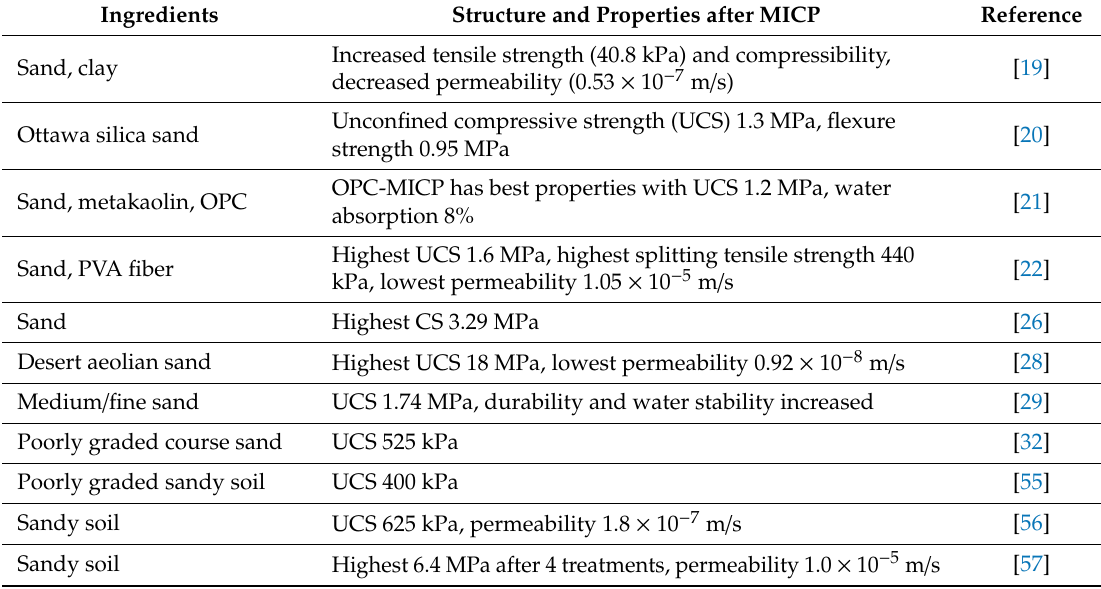
Table 1. MICP with Sporosarcina pasteurii for sand and soil